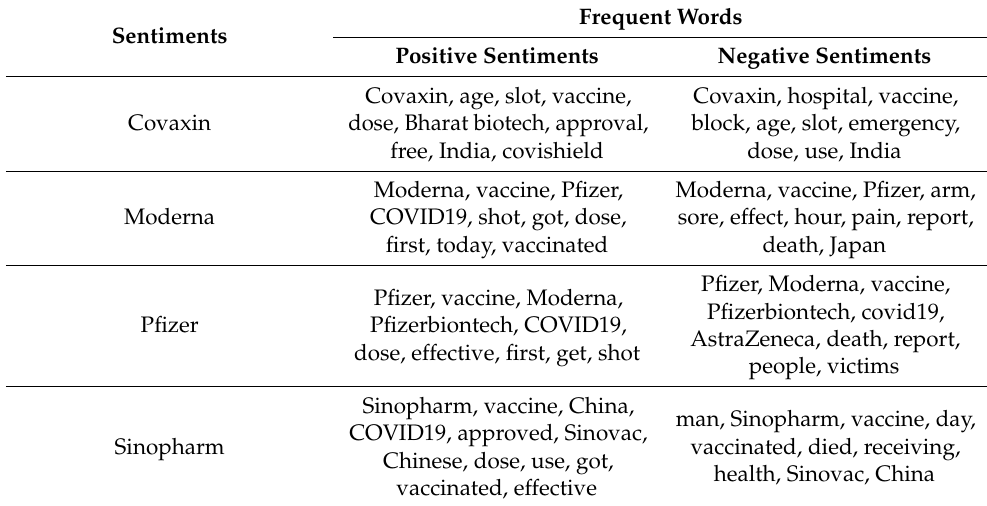
Table 3. Most frequent words in COVID-19 vaccine-related tweets across sentiment types.